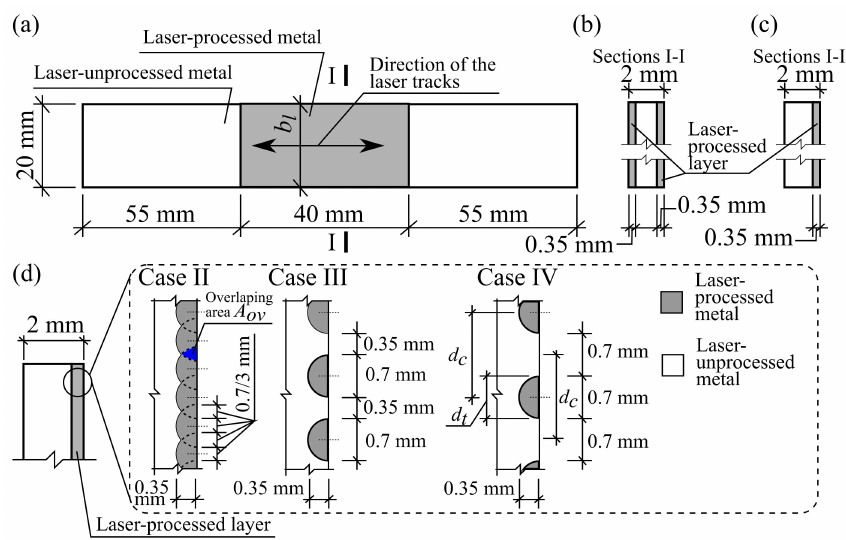
Figure 1. The general view of the plate specimen ( a ); sketches of their cross-sections: of the one-side laser-processed plate ( b ), and of the two-side laser-processed plate ( c ); and cases of the laser tracks ( d